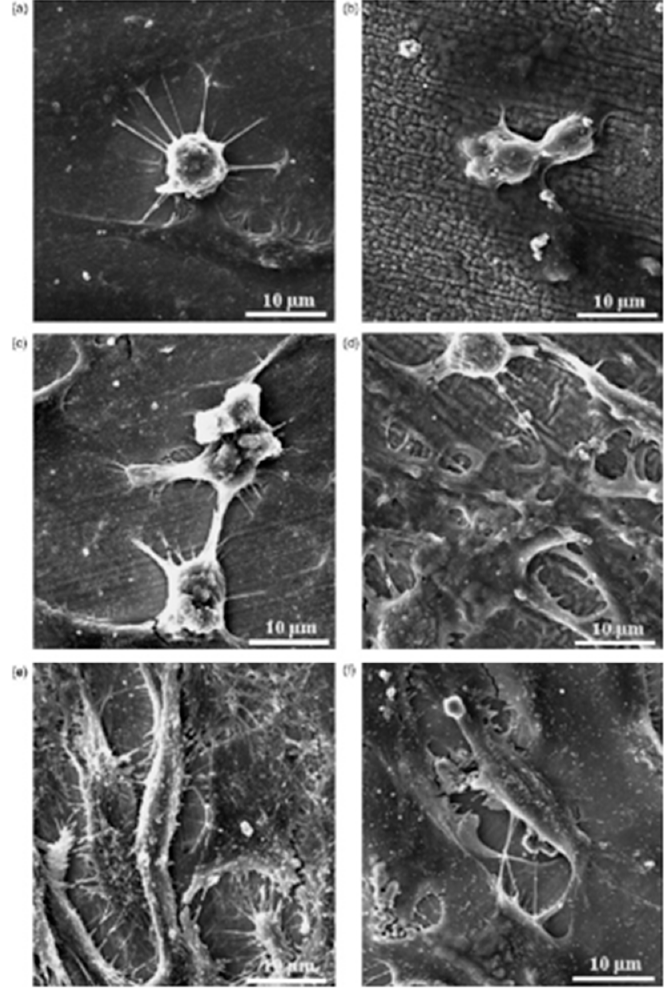
Figure 18. SEM images of the untreated and EDMed Fe-Al-Mn alloys at different culture times: ( a , b ) 8h, ( c , d ) 24 h, and ( e , f ) 48 h [122]. (With kind permission from Elsevier). ( a , b ) 8 h, ( c , d ) 24 h, and ( e , f ) 48 h [122]. (With kind permission from